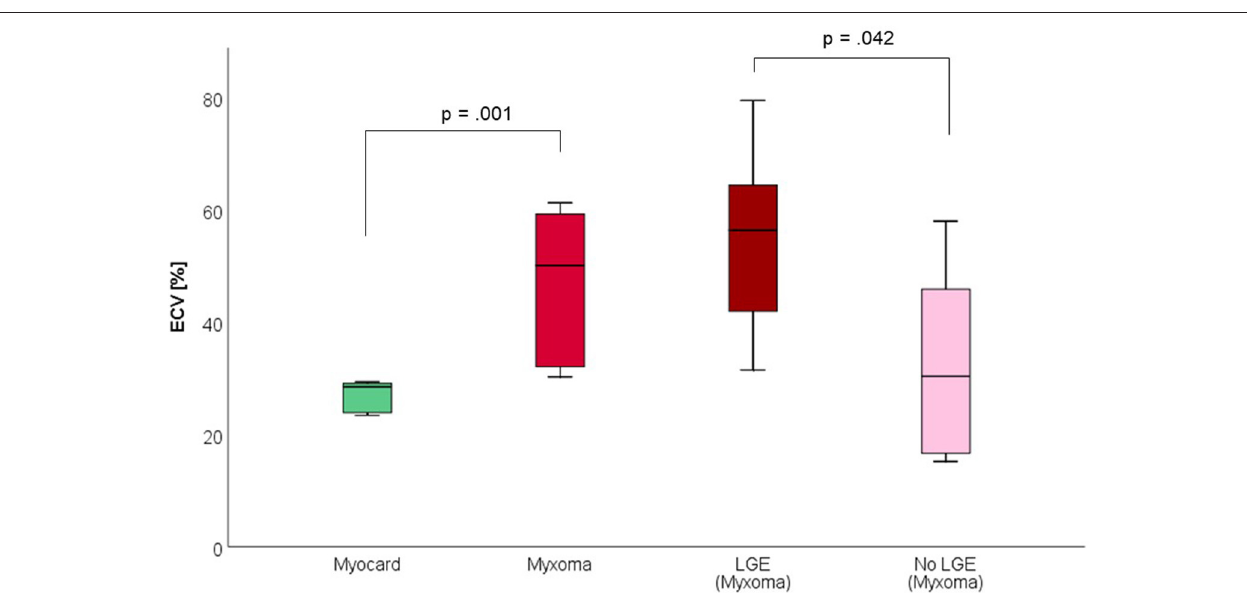
times lead to lower signal on T1 weighted sequences. The difference in T1 relaxation times found in our study might be too small to lead to visibly detectable differences on T1 weighted sequences, hence the impression of iso-intensity. Our findings are supported by measurements in other tissues that generally show simultaneously elevated T1 and T2 relaxation times in areas with increased fluid content